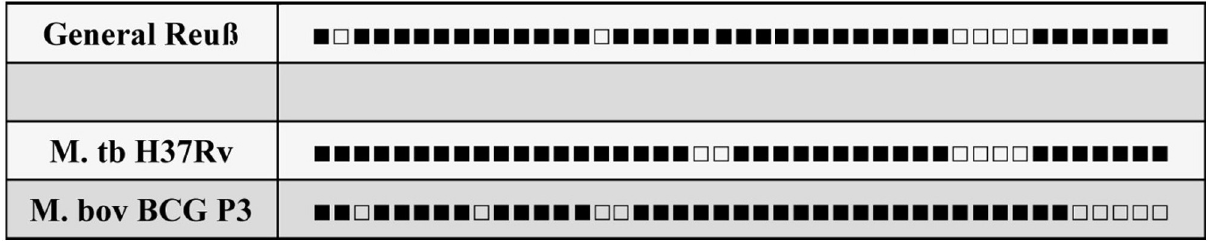
Fig 19. Spoligotyping results of the mycobacterial aDNA of the cyst wall.